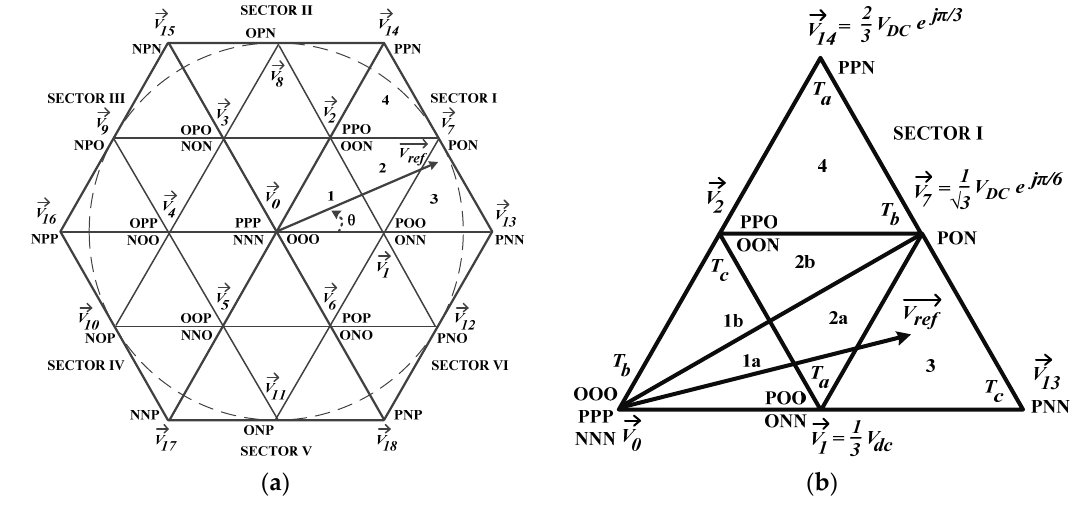
Figure 16. Space vector diagram for three-level NPC inverter; ( a ) division of sectors and regions, and ( b ) division of six regions in Sector I for minimizing voltage deviation at neutral-point (cid:1852) [69].